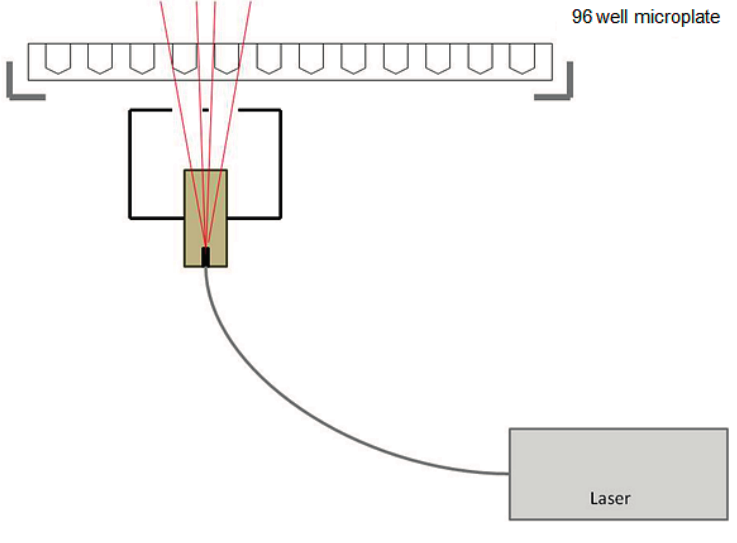
Figure 6. Photodynamic therapy irradiation